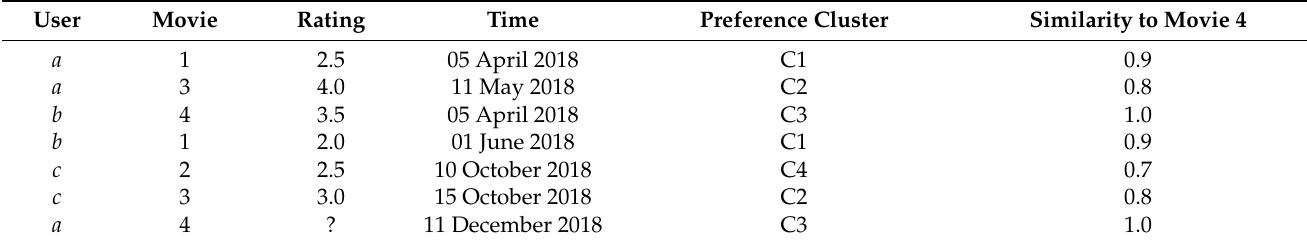
Table 1. The structure of sample